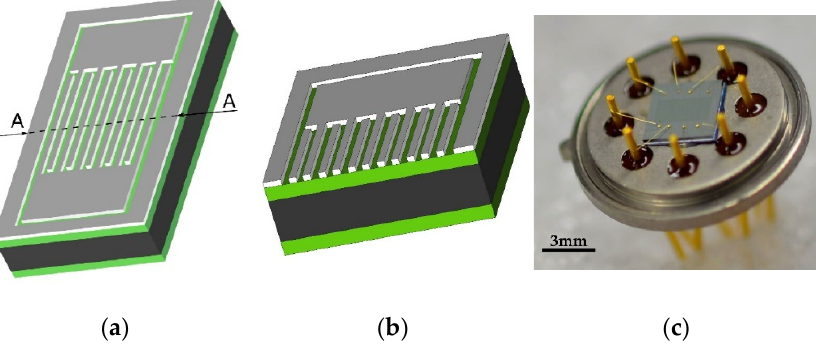
Figure 2 . ( a ) 3D design of the single sensor battery; ( b ) cross-section through A–A line; ( c ) photograph of the finished sensor on a TO-8 housing. Scale bar 3 mm.